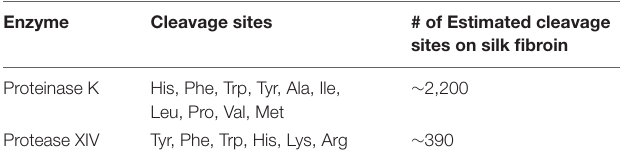
TABLE 3 | Proteolytic enzyme (Proteinase K, Protease XIV) information (Brown et al., 2015; Wongpinyochit et al., 2018; Guo et al., 2020). Enzyme Cleavage sites